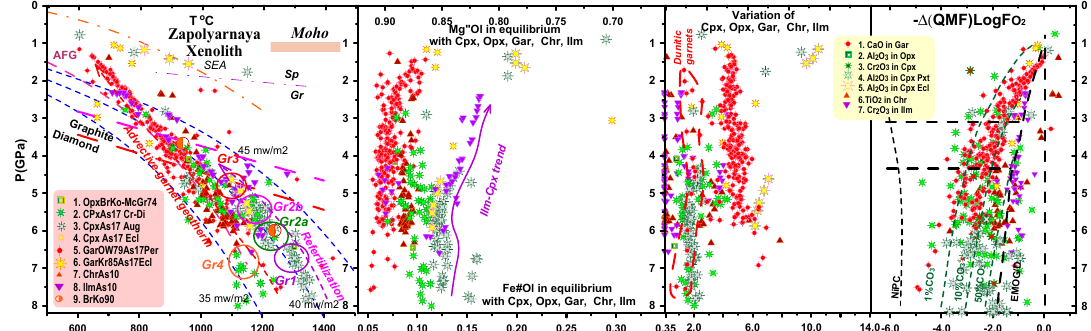
Figure 13. P-T-X-fO 2 diagram for the minerals from deep-seated xenoliths from Zapolyarnaya pipe. Some xenocrysts from essentially “dunite veins” have been included. Symbols: 1. Opx: T °C-[34]-P(GPa) [35]. 2. Cpx: T °C-[36]-P(GPa)-[37] (for Cr-diopsides); 3. The same for Fe-rich Cr-diopsides. 4. The same for eclogites and pyroxenite). Garnets: 5. T o C-[38]-P(GPa)-[37] 6. The same for eclogites; Chromite: 7. T °C-[39]-P(GPa)-[12]; 8. Ilmenite megacrysts [40]-P(GPa)-[41]; 9. T °C-P(GPa)-[34]. The field for P-fO 2 ( ∆ LogfO 2 relative to quartz-fayalite-magnetite QMF buffer) diagrams after [42,43]. The oxybarometers for Sp and Ilm [40]; Cpx [44]; Gar [45]. The horizontal dashed line at 3.5 and 4.5 GPa corresponds to the Graphite-Diamond boundary [46] at 35 and 40 mWm − 2 respectively. The upper line the same boundary after [47]. Conductive geotherms after [48]. The South Eastern Australian geotherm (SEA) after [49]. The garnet spinel transition is after [50]. Moho boundary (brown rectangle) after [51]. Abbreviations in legend: Per-peridotites; Ecl-eclogites; Aug- augites; Cr-Di- Cr-diopsides. Methods abbreviations—see legend and literature references. The values of Mg’Ol and Fe’Ol mean the Mg’ and Fe’ numbers for the Ol in equilibrium with the minerals are calculated according to [12]. For the marked geochemical groups of Cpx and Gar, see Figure 10b.